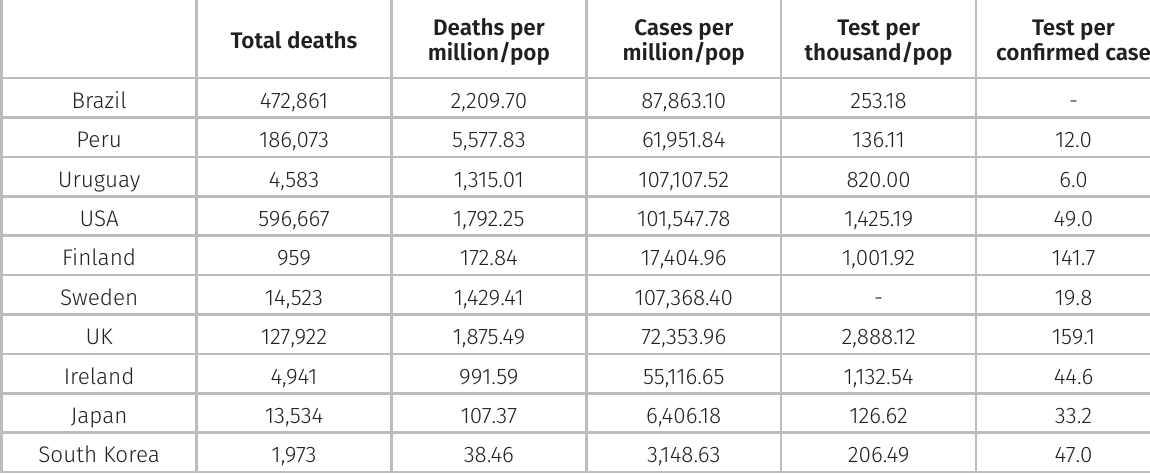
Table III. COVID-19 data from selected